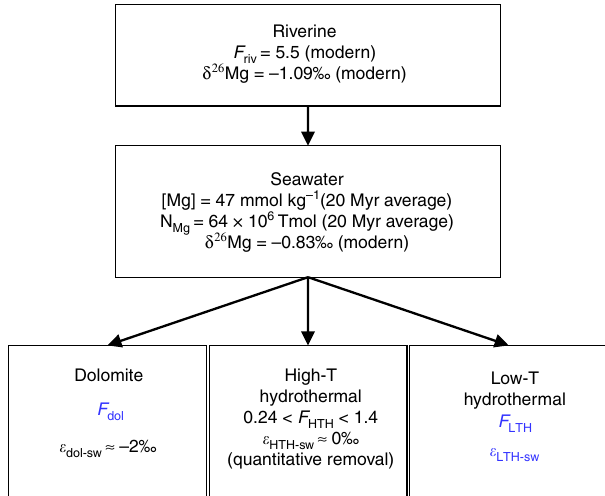
Fig. 1 Schematic of the oceanic Mg budget. Modi fi ed after: Tipper et al. 15 . In blue are the missing parameters determined in this study. Mg input or output fl uxes, F , are in Tmol yr − 1 and are taken from the following: Berner and Berner 16 , Elder fi eld and Schultz 6 , Arvidson et al. 3 , and Vance et al. 17 and references therein. The subscripts riv, dol, HTH, LTH, and sw stand for riverine, dolomite, high-temperature hydrothermal, low-temperature hydrothermal, and seawater, respectively. N Mg is the Mg inventory in seawater. δ 26 Mg values are taken from Tipper et al. 15 , Foster et al. 18 , and Ling et al. 19 . ε sink-sw is the isotope fractionation between seawater and the speci fi ed Mg sink. ε dol-sw is taken from Higgins and Schrag 20 , Li et al. 21 , and others. Only the major oceanic inputs and outputs are shown. For details see